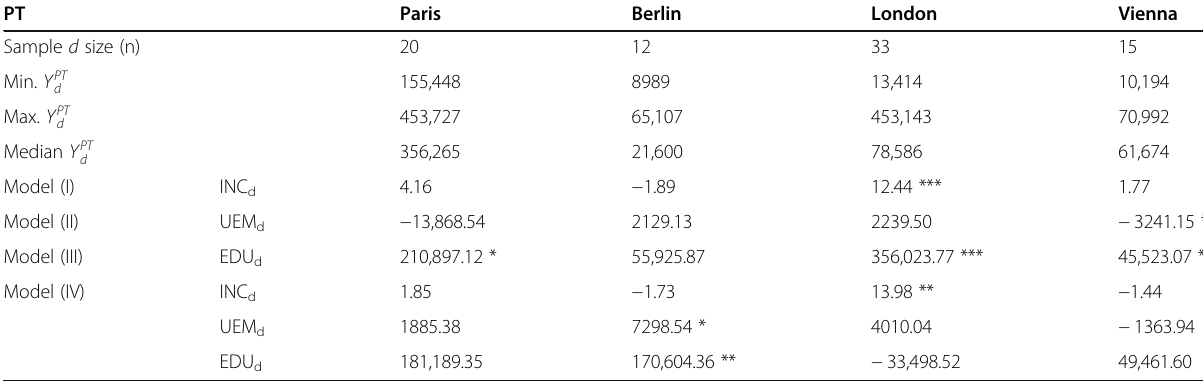
Table 1 Summary of city regression tables for four models on PT. PT